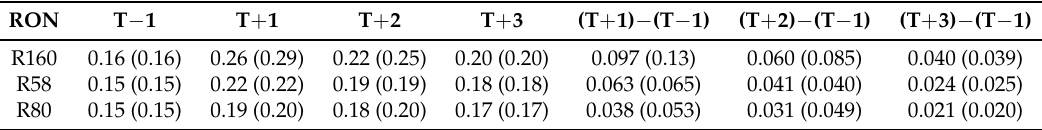
Table 5. Median coherence values for time separation groups and VV polarisation. Values without parentheses indicate unfiltered data, while precipitation filtered data is given in